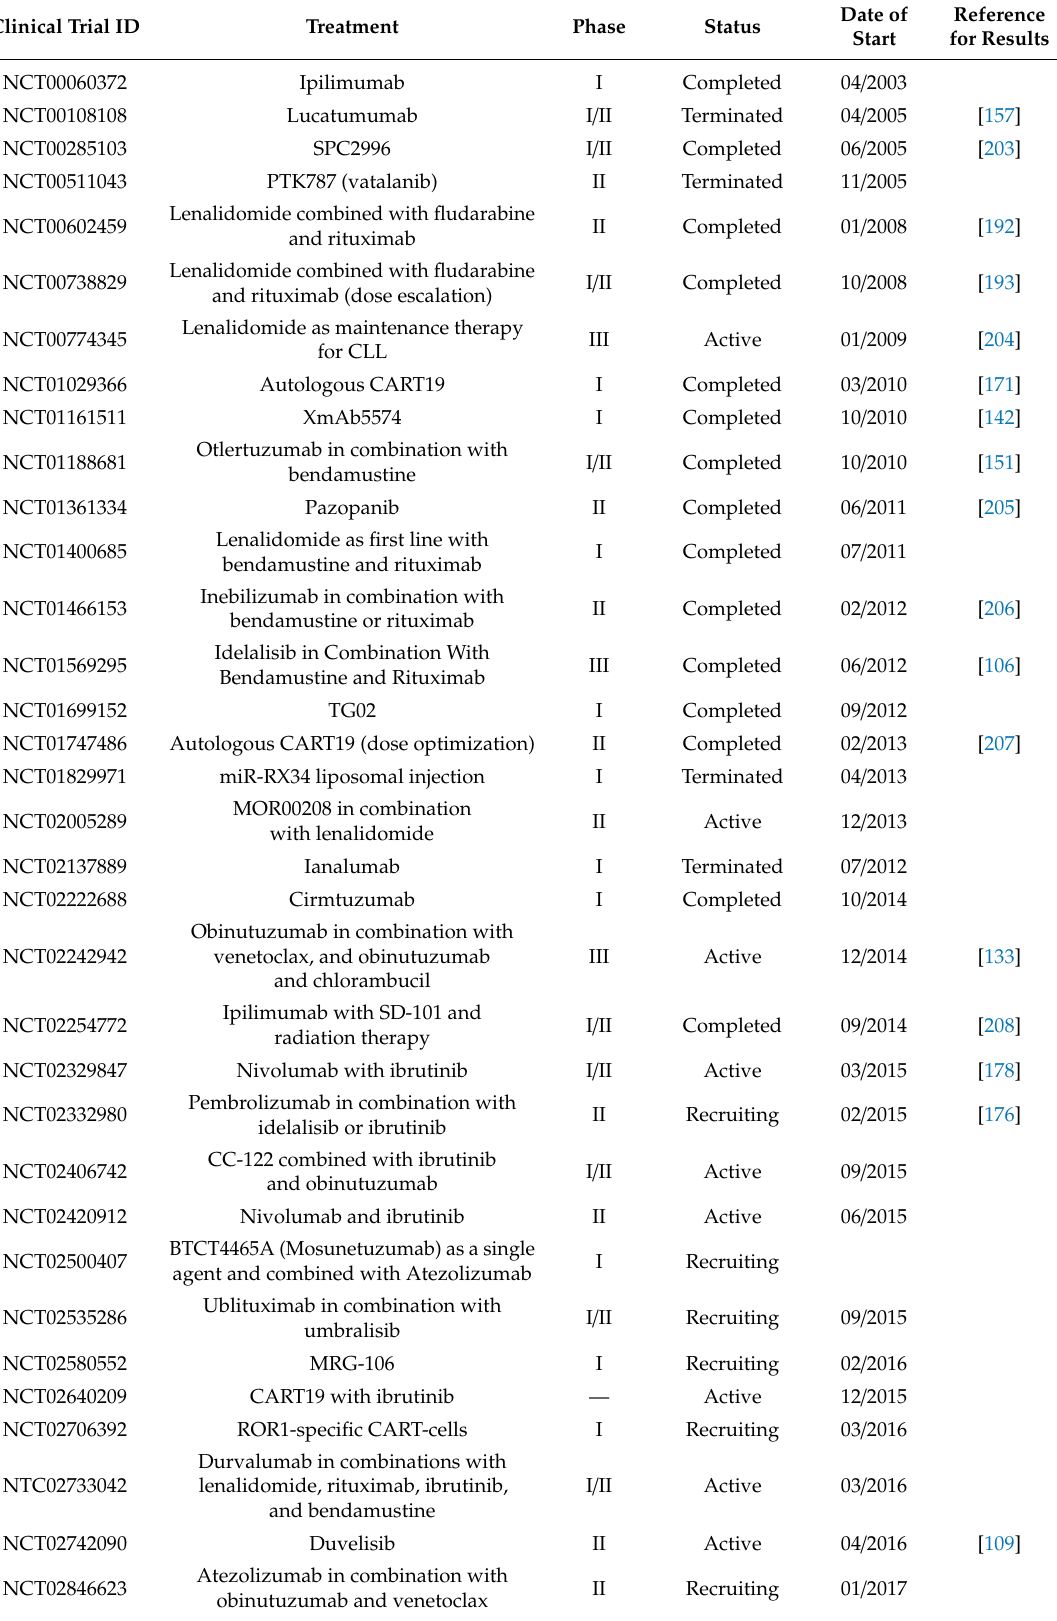
Table 2. Ongoing clinical trials for novel therapeutic approaches of CLL updated January 2020. Clinical Trial